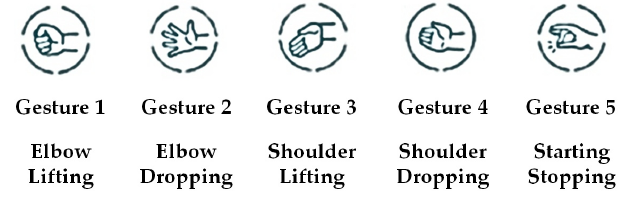
Figure 20. Basic gesture settings for general users.